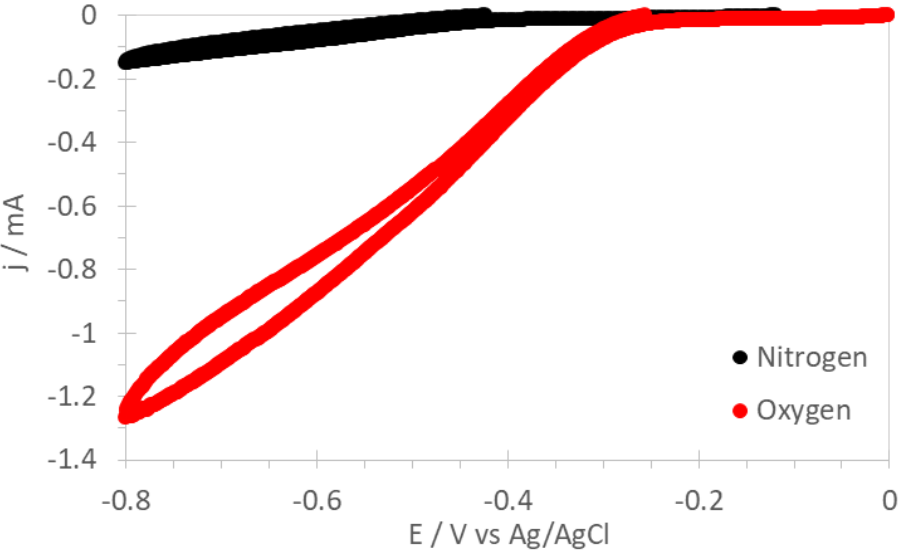
Figure 5. Cyclovoltammograms of PSU-TMA + PANI + GAH-Oct in N 2 - and O 2 -saturated 1 M KOH solution at 1500 rpm.